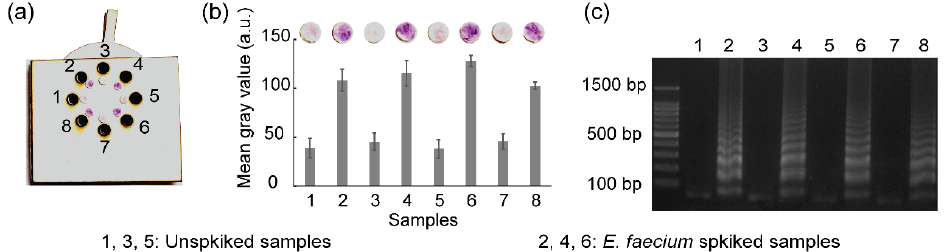
Figure 9. Results showing ( a ) the detection of E. faecium spiked in milk using the rotatable device, ( b ) mean gray analysis, and ( c ) agarose gel electrophoresis. All the experiments were repeated three times.